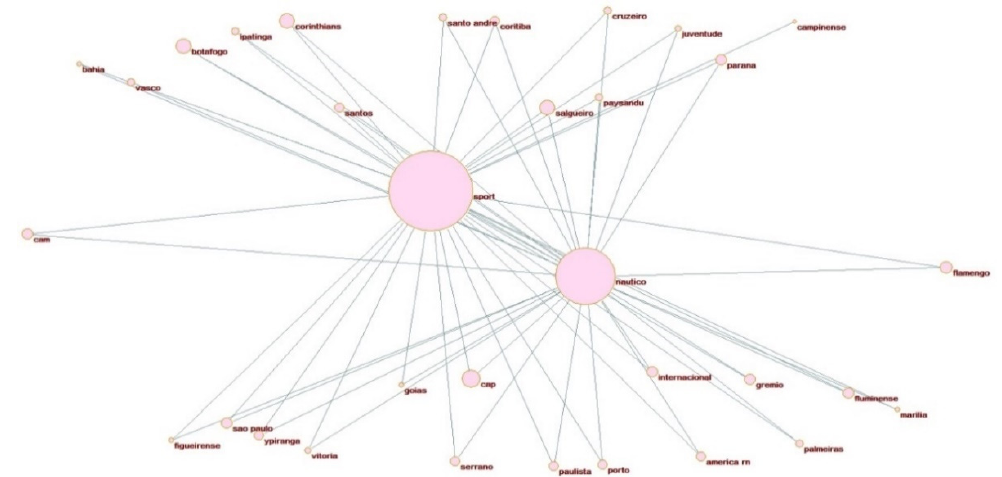
Figure 6. Clash affinity between Sport Recife and Náutico Capibaribe.